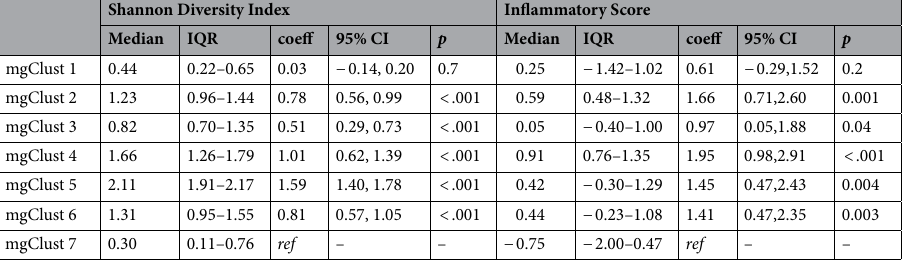
Table 4. Shannon diversity indices and inflammatory scores by metagenomic cluster (mgClust) at 16–20 gestational weeks. Coefficients, 95% confidence intervals, and associated p values calculated by weighted linear regression, adjusting for HIV serostatus at enrollment.